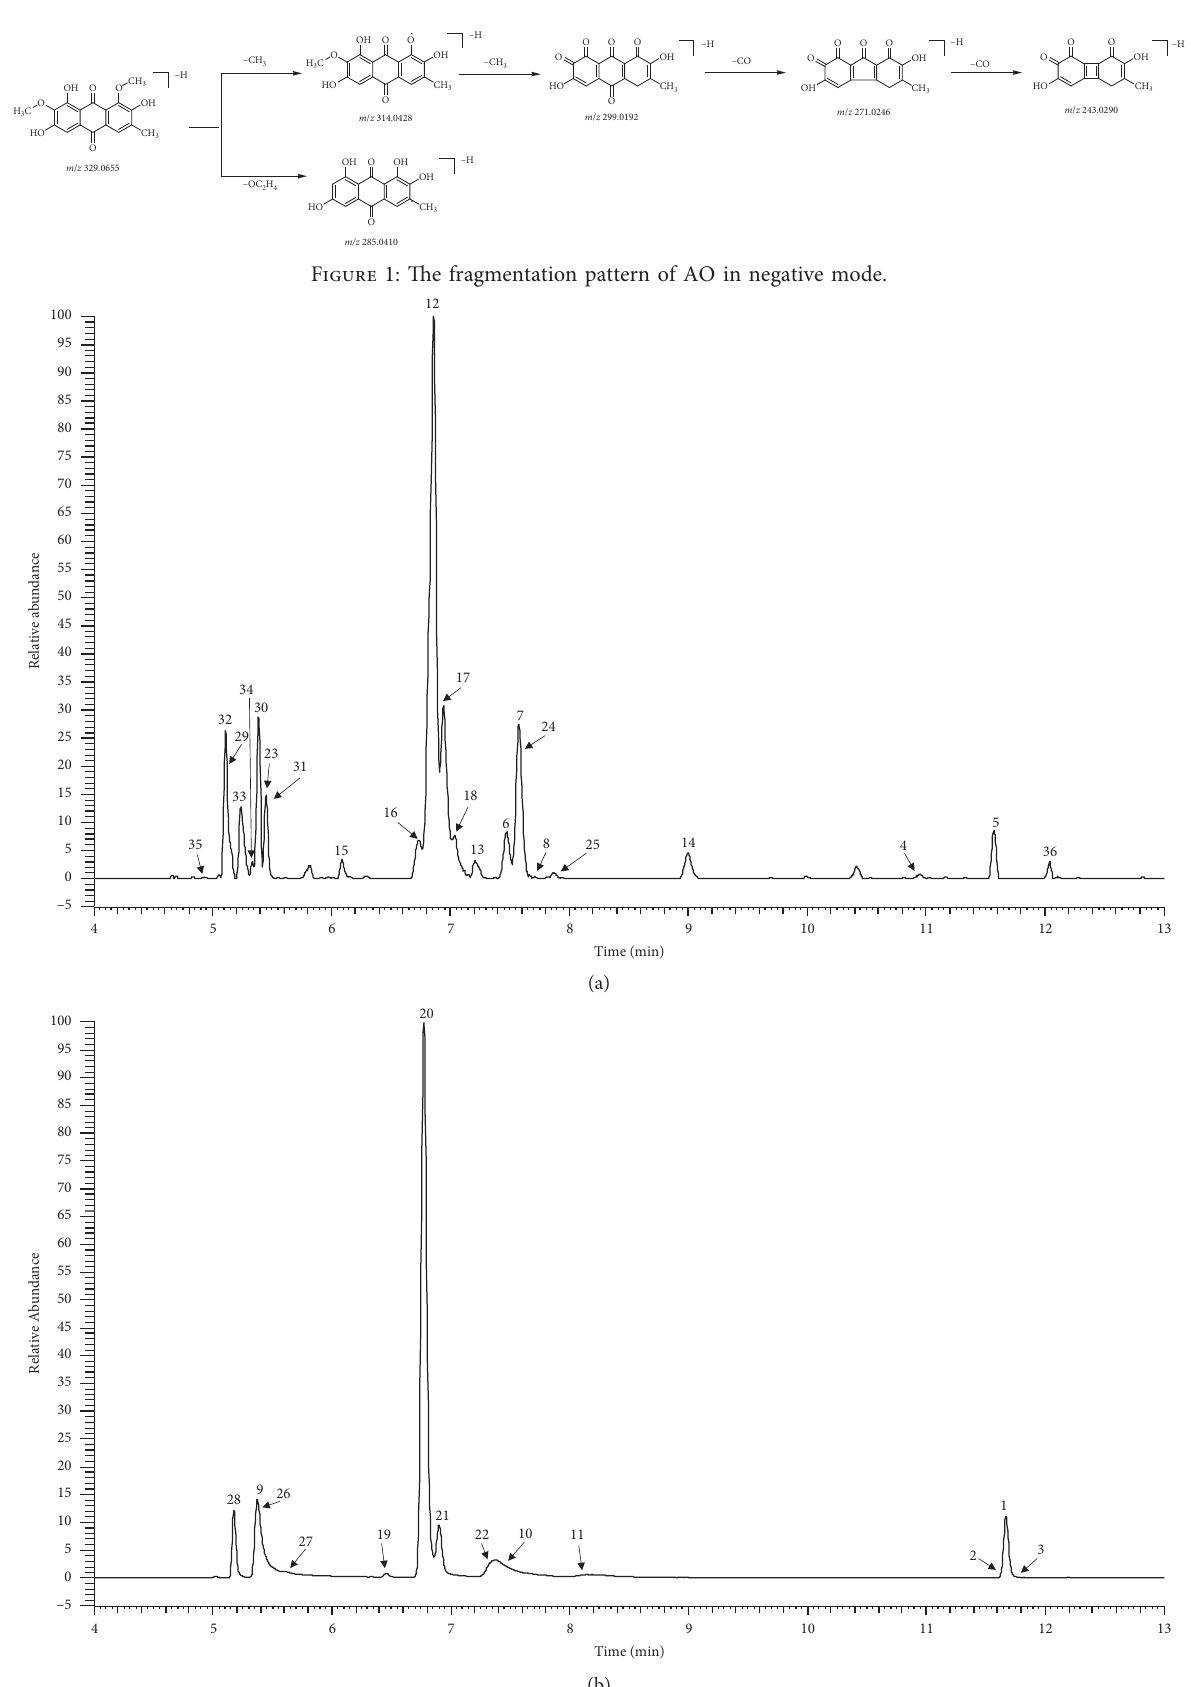
Figure 2: The high-resolution extraction ion chromatography of AO metabolites: (a) m/z 299.05611, 315.05102, 345.06159, 475.0882, 491.08311, 521.09258, 651.12029, 667.1152, 697.12577; (b) m/z 409.02326, 329.06557, 505.09876, 585.05418, 681.13109.